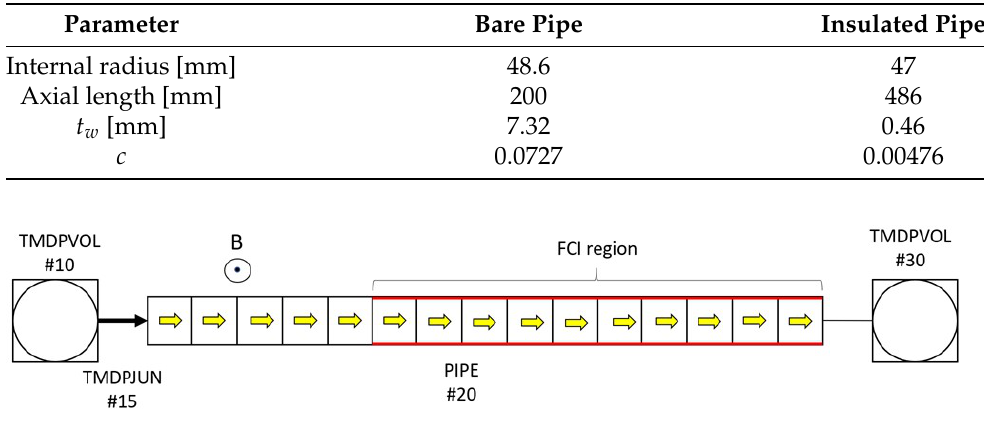
Figure 5. Sketch of the model, outlining RELAP5 discretization. The region where flow channel insert is applied is underlined in red. With yellow arrows is delineated the fluid